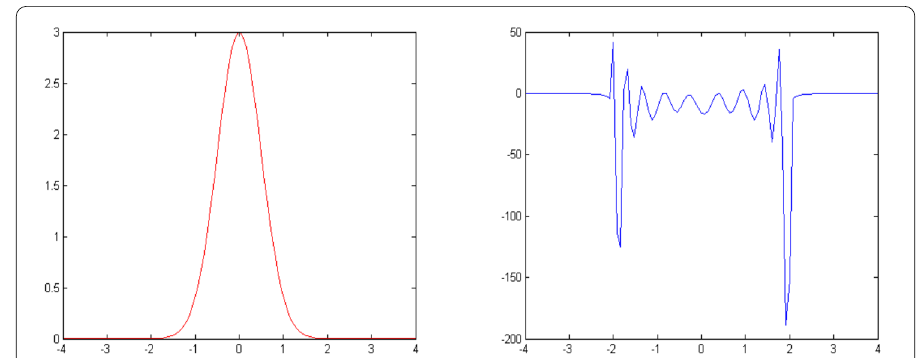
Figure 5 Cauchy data calculated by the direct algorithm, function f (left), function g for Example 1 (right)